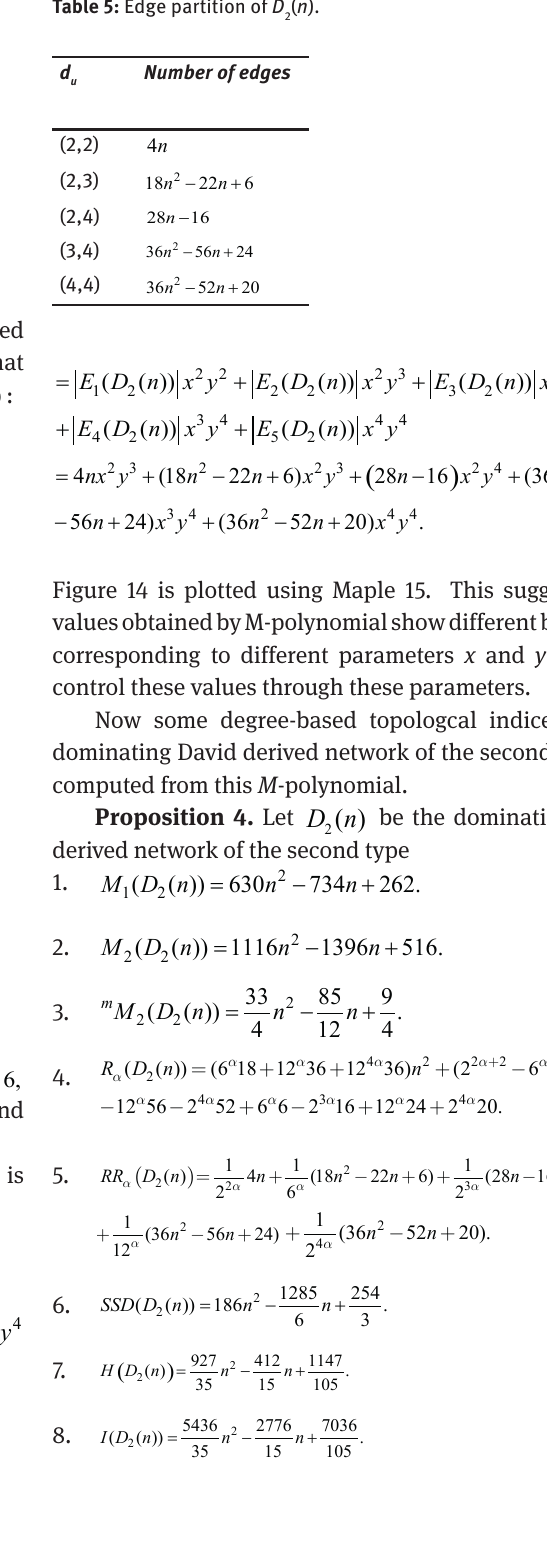
Table 5: Edge partition of D